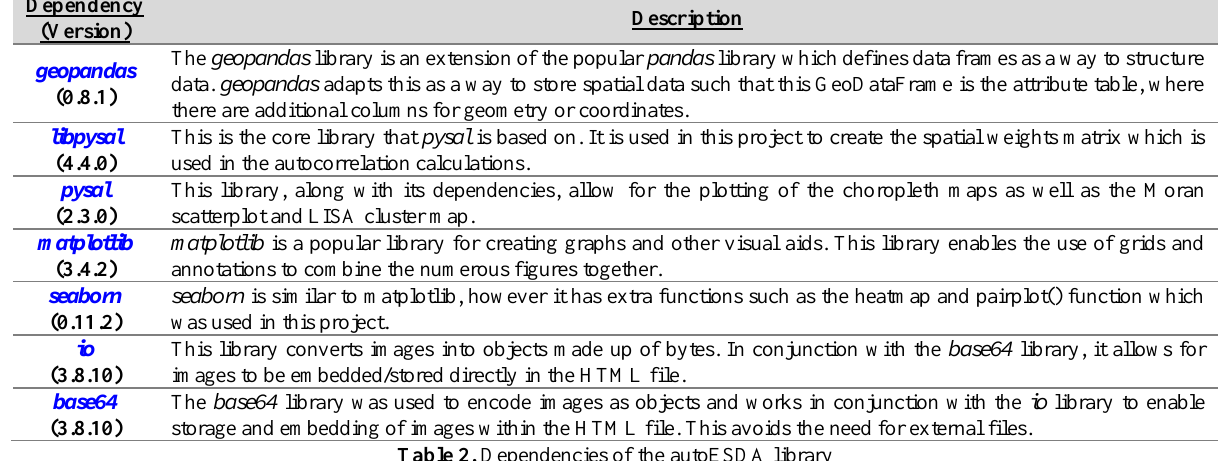
Table 2. Dependencies of the autoESDA library